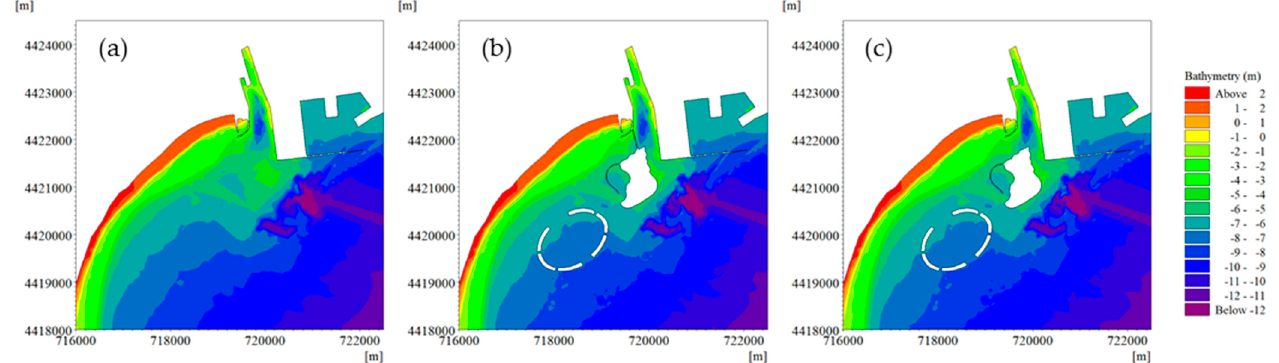
Figure 4. The bathymetries of ( a ) the initial construction conditions, ( b ) the first-stage construction conditions, ( c ) the current construction conditions.